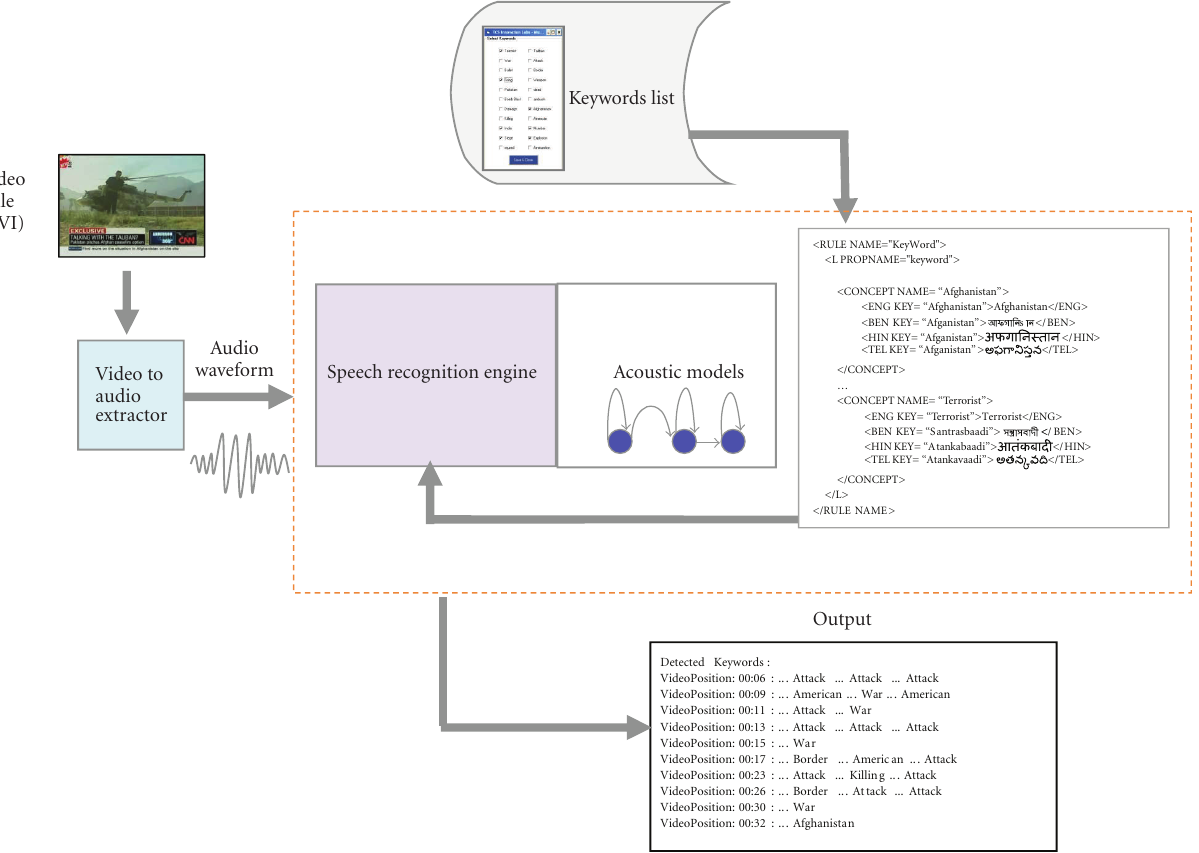
Figure 3: Typical block diagram of a keyword spotting